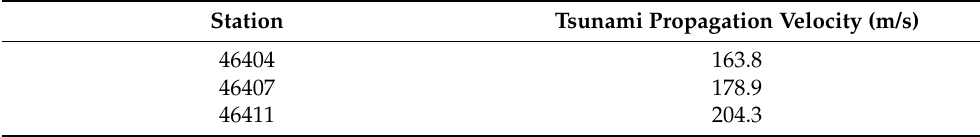
Table 2. Tsunami propagation velocity of range.